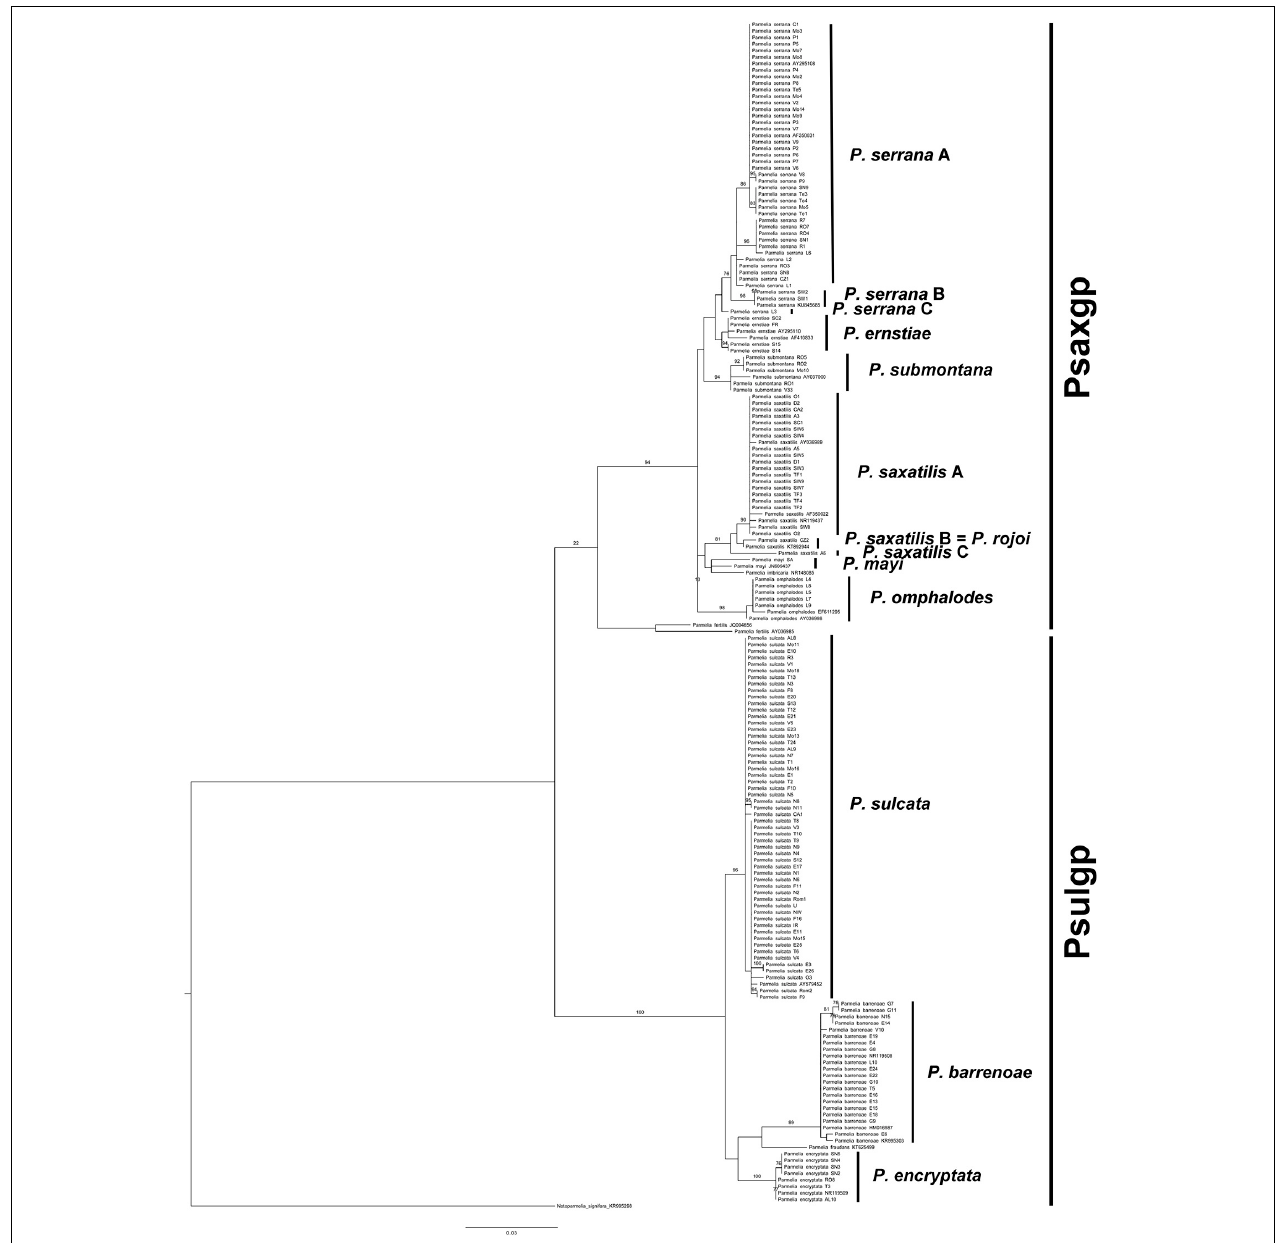
FIGURE 1 | Maximum likelihood (ML) internal transcribed spacer (nrITS) tree of the Parmelia specimens. (ML) bootstrap values ≥ 70% from the RAxML analysis are indicated above